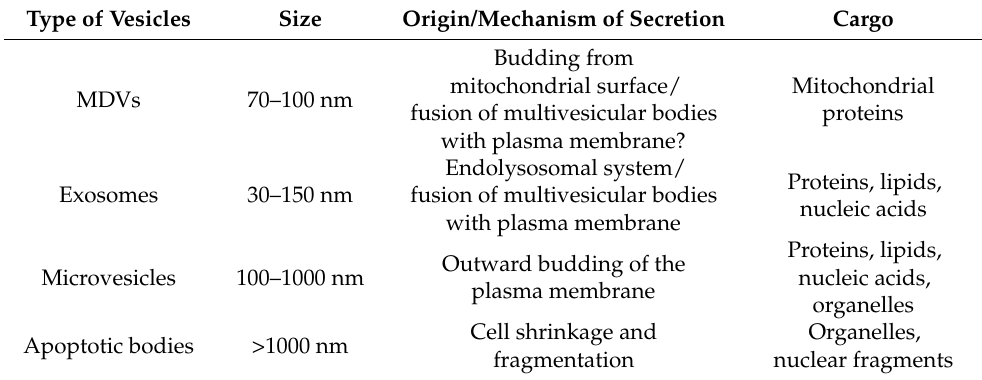
Mitochondrial proteins Proteins, lipids, nucleic acids Proteins, lipids, nucleic acids, organelles Organelles, nuclear